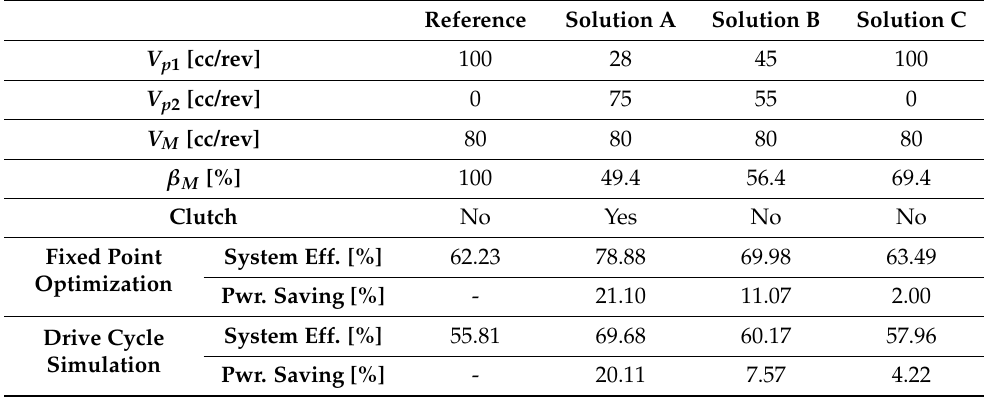
Table 3. Optimization result sizing for the Proposed